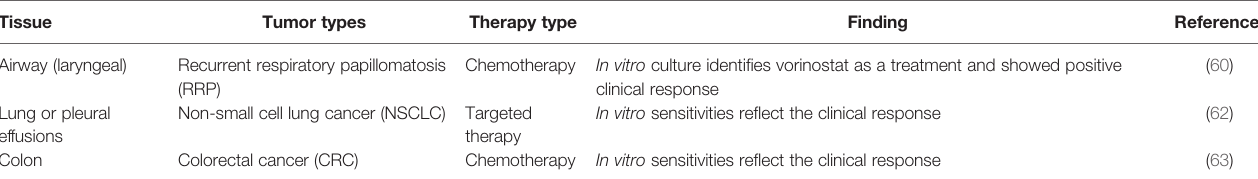
TABLE 2 | Applications of conditional reprogramming in precision